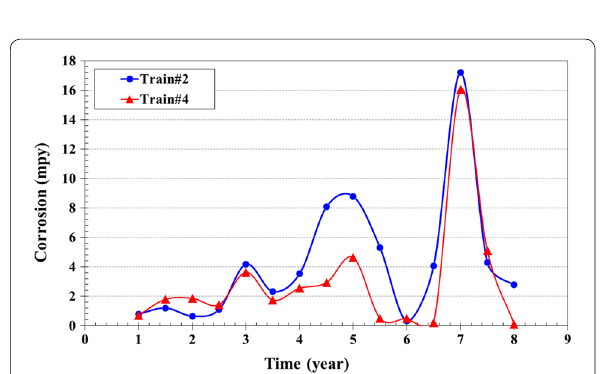
Fig. 10 The corrosion rate of regenerator of MDEA unit trains #2 and